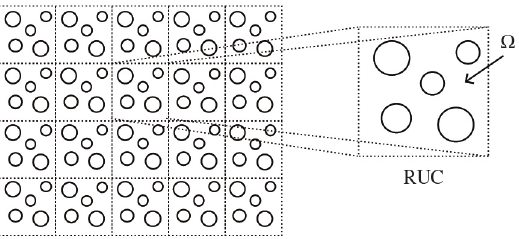
Figure 1. Periodic composite material and repeated unit cell